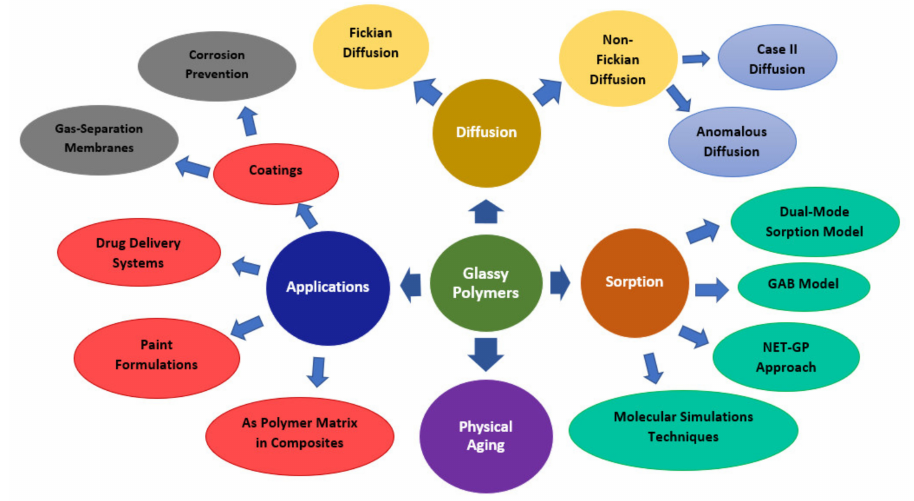
Figure 1. Graphical representation of an overview of the contents of the present